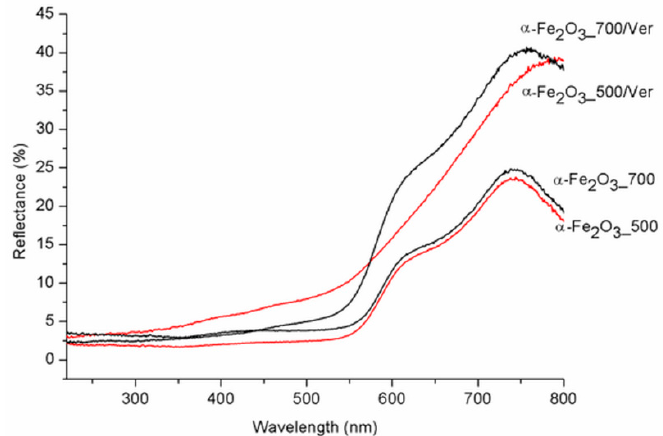
Figure 6. Diffuse reflectance spectra of pure α -Fe 2 O 3 nanoparticles and α -Fe 2 O 3 nanoparticles/Ver samples for different temperatures.